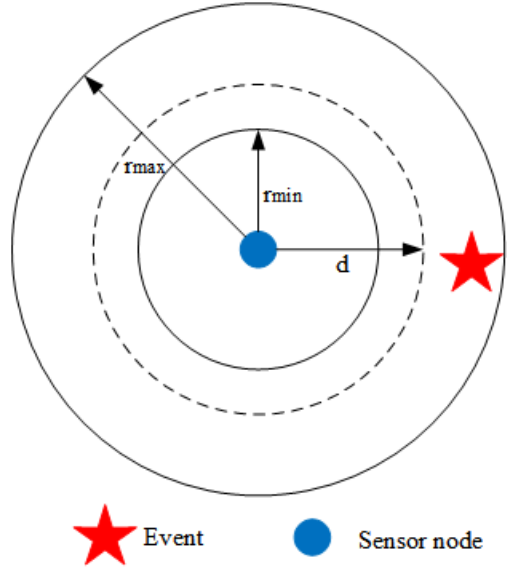
Figure 1. Tunable sensing